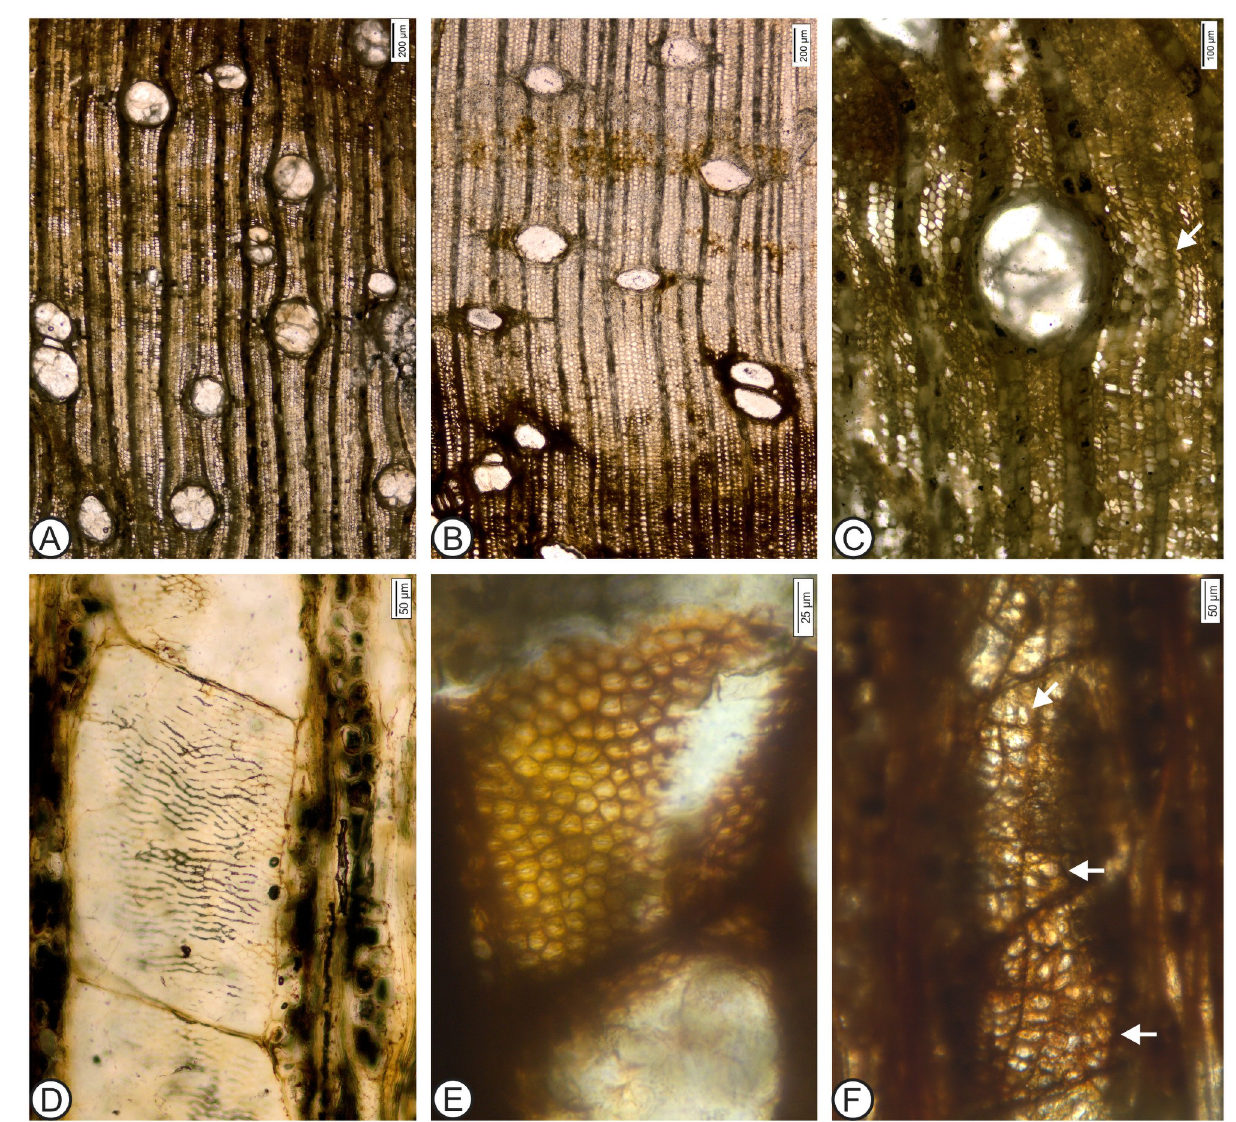
Fig 2. Anacardium gassonii Rodrı´guez-Reyes, Estrada-Ruiz et Terrazas sp. nov. A, C-F, MUPAN-STRI 44071; B, MUPAN-STRI 44051. (A) Growth ring boundaries absent; wood diffuse-porous (TS). (B) Solitary vessels and aliform parenchyma (TS). (C) Detail of the aliform parenchyma (arrow) (TS). (D) Simple perforation plate (TLS). (E) Intervessel pits alternate, polygonal and crowded (TLS). (F) Vessel–ray parenchyma pits with much reduced borders, round to horizontally elongated (TLS).